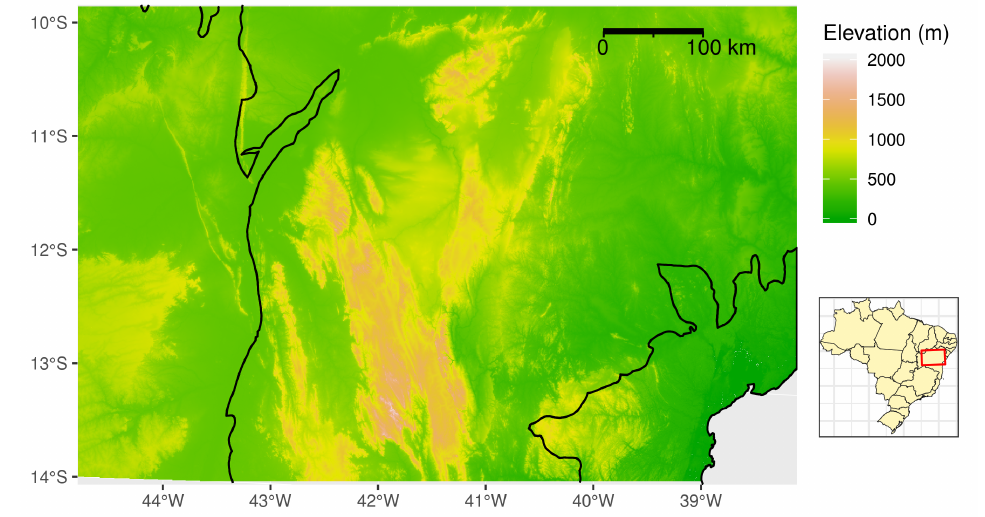
Figure 2. Location and elevation data of the study area. The black lines indicate the distribution of the biomes. From west to east: Cerrado, Caatinga and Mata Atlântica. Inset: Study area location in Brazil (red